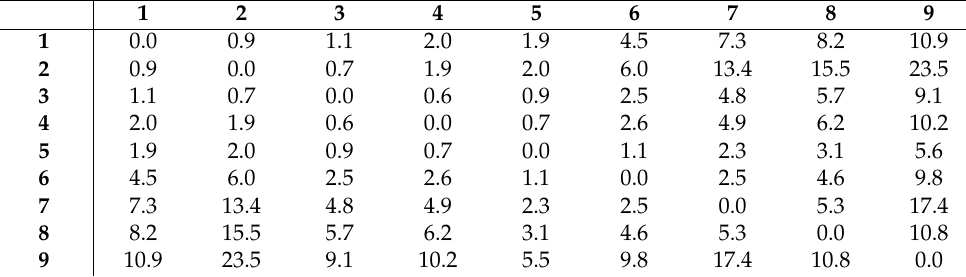
Table 2. Effort matrix E 1 for route one.